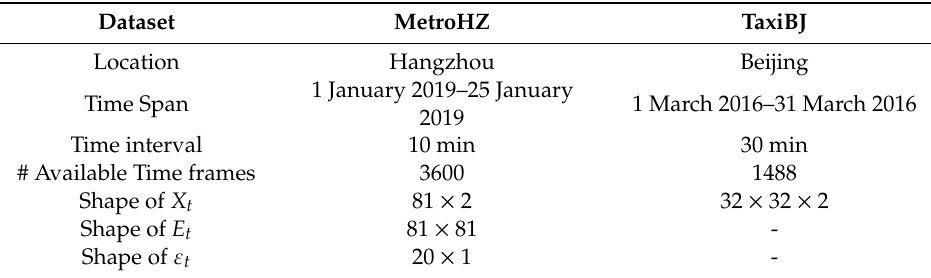
Table 2. Dataset